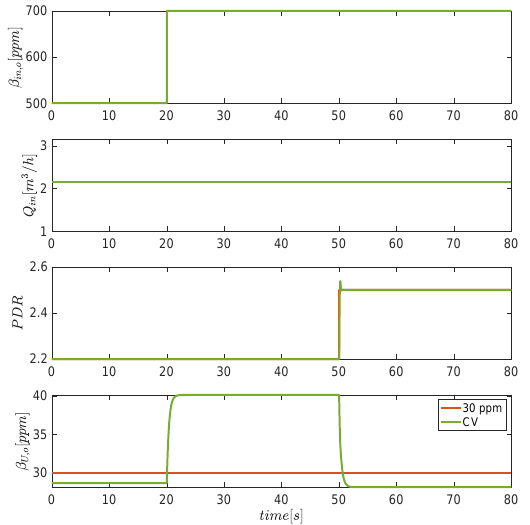
Figure 4: Simulation result showing increase in the β U,o with increase in β in when fixed PDR set- point. At 50 s, the PDR setpoint is manually adjusted to reduce β U,o below 30 ppm.